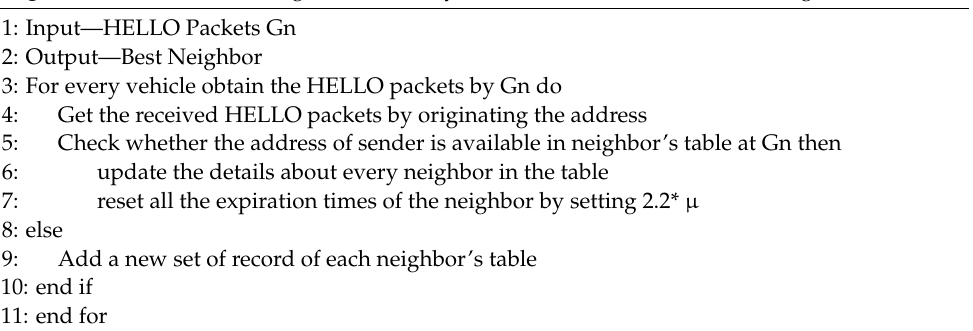
Algorithm 1 MAC Based Neighbor Discovery Process-HELLO Packets